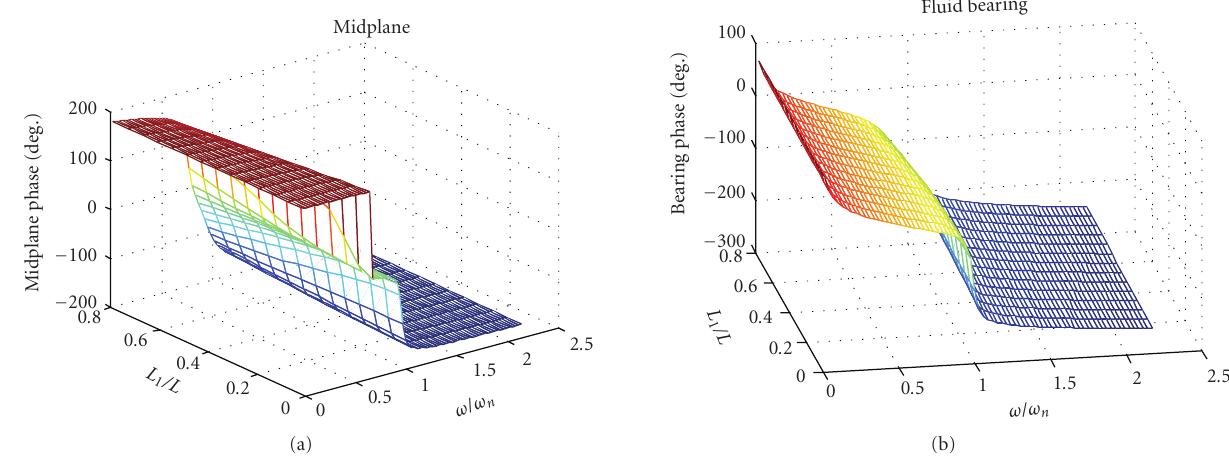
Figure 8: Phase at midspan (a) and at the fluid bearing (b) corresponding to the frequency response plots shown in Figure 7.